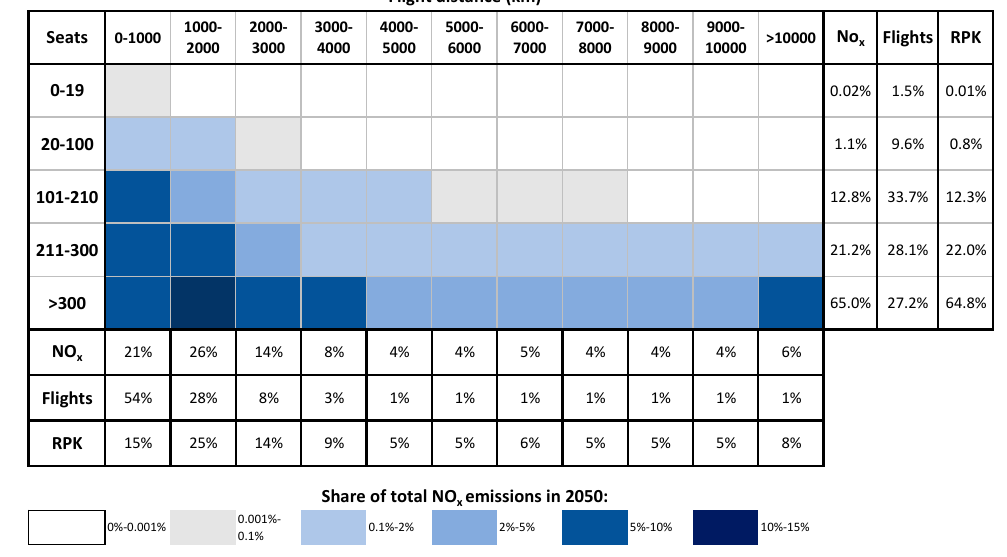
Figure 22. Distribution of NO x emissions by seat class and flight distance in 2050.